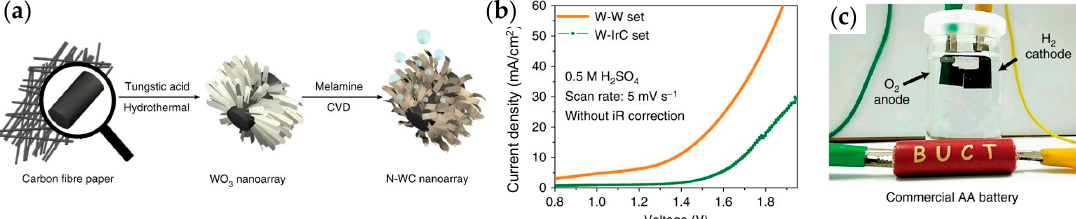
Figure 22. ( a ) Synthesis route of the N-doped WC nanoarrays. ( b ) i-V curves of water splitting with the N ‐ WC as anode and cathode electrodes compared with N ‐ WC as the cathode and Ir/C as the anode; ( c ) Video snapshot of the water electrolysis with a 1.5 V commercial battery. Reprinted with permission from [217]. Copyright 2018 Nature Publishing Group.